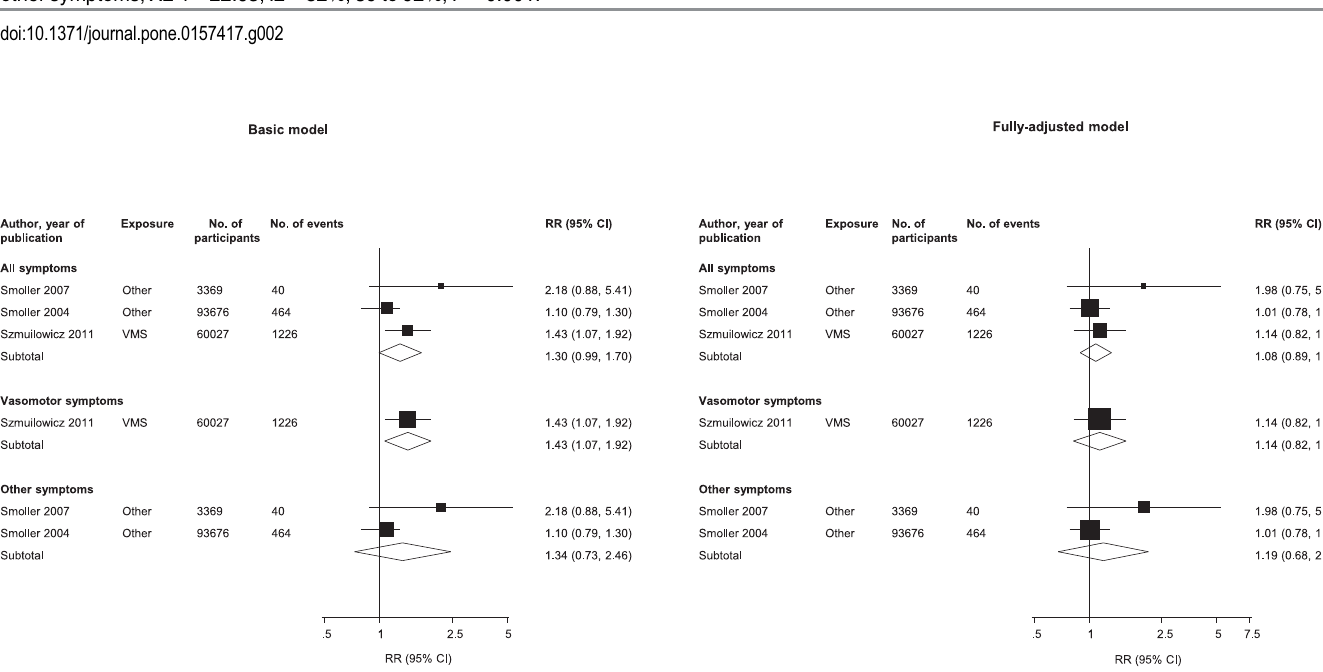
Fig 3. Relative risks of stroke associated with menopausal symptoms. Basic model: adjusted for age and non-established cardiovascular risk factors; Fully-adjusted model, adjusted for established cardiovascular risk factors and potential mediators. VMS, vasomotor symptoms; vasomotor symptoms include hot flashes and /or night sweats; All, includes vasomotor and other menopausal symptoms; Other, includes menopausal symptoms such as depression, insomnia, and panic attacks. Assessment of heterogeneity for basic model: All symptoms, X 2 2 = 3.26, I 2 = 39%, 0 to 81%; P = 0.196; other symptoms, X 2 1 = 2.03, I 2 = 51%, 0 to 87%; P = 0.154. Assessment of heterogeneity for full-adjusted model: All symptoms, X 2 2 = 1.86, I 2 = 0%, 0 to 90%; P = 0.395; other symptoms, X 2 2 = 42%; P = 0.189. 1 = 1.72, I